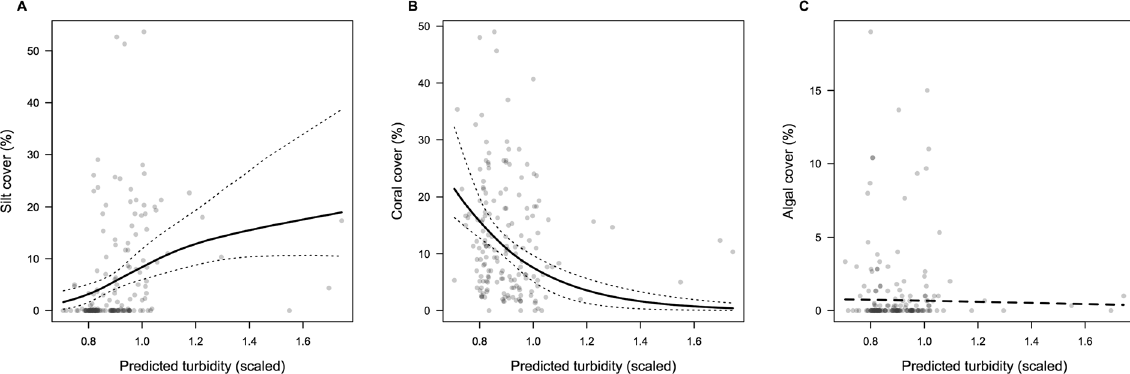
Figure 4. Turbidity estimates from the Bayesian model predict ( A ) silt cover (zero inflated log-linear model), ( B ) cover of sediment-sensitive scleractinian coral genera (linear model fit with logit transform) and ( C ) algal cover (zero inflated logit model). Lines show model fits, where a solid line is statistically significant (p < 0.05). Dashed lines in ( A , B ) give 95% confidence intervals.